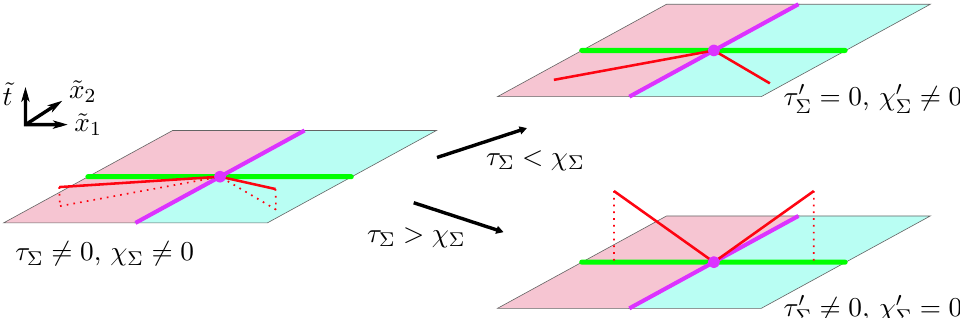
Figure 13. The left panel shows two components of the entangling surface (red) at non-zero Rindler time τ Σ in the right CFT in the Poincaré coordinates (3.47). These two rays are located